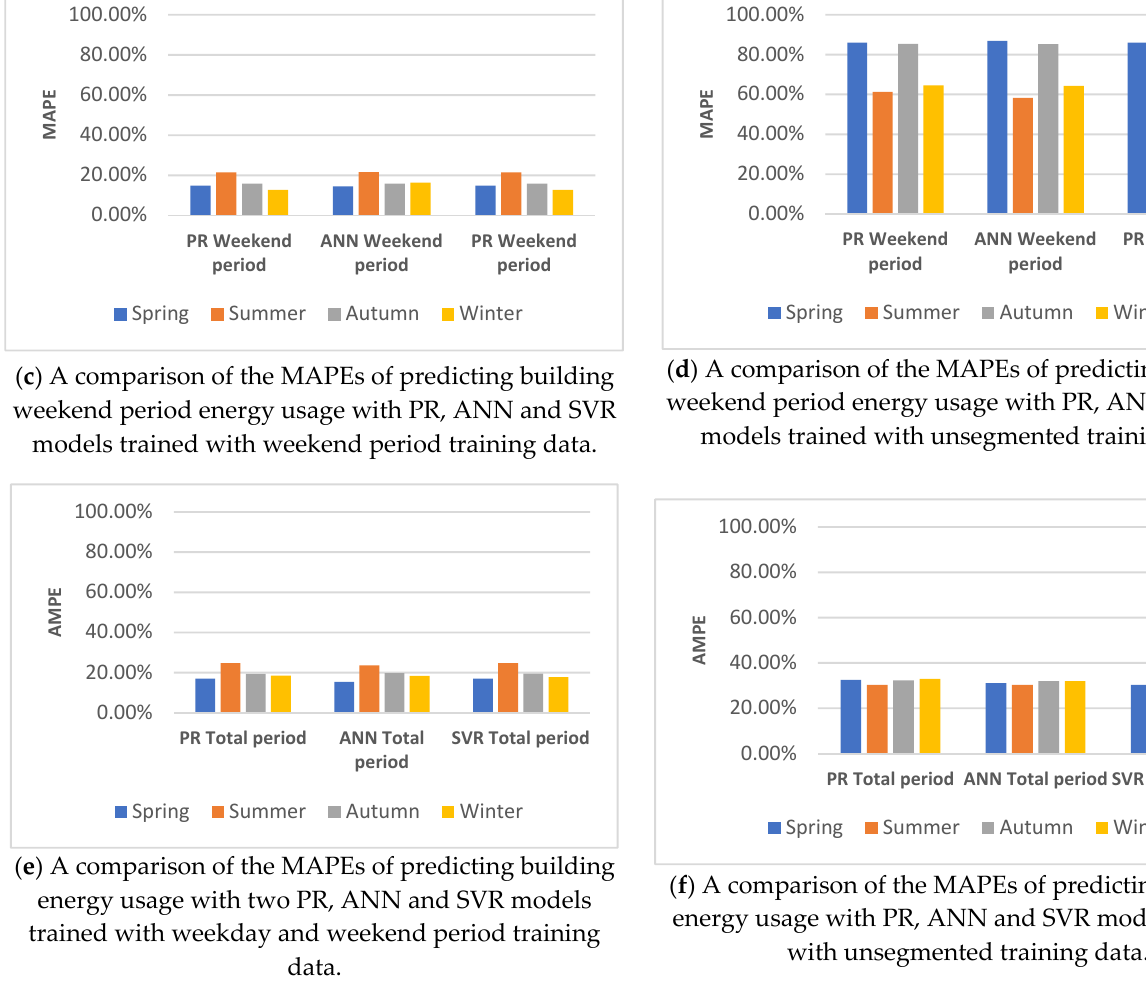
Figure 21. A comparison of weekday/weekend segmented machine learning techniques’ monthly MAPE.